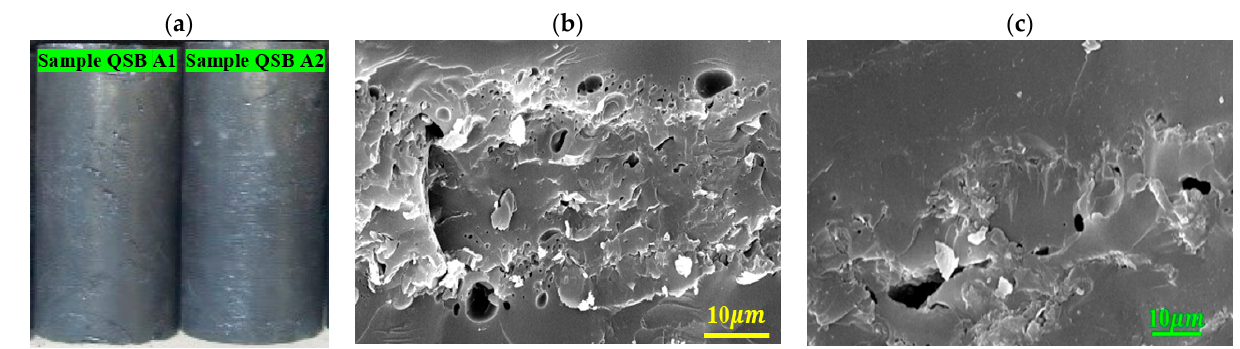
Figure 4. ( a ) The two studied samples; ( b , c ) Various pore types, i.e., micro, meso, and macropores inside the Sample QSB A1 and Sample QSB A2, respectively, under the scanning electron microscope. These SEM images only represent the qualitative situation of the internal pore space of the samples and the real bulk porosity was quantitatively measured by the NMR machine.